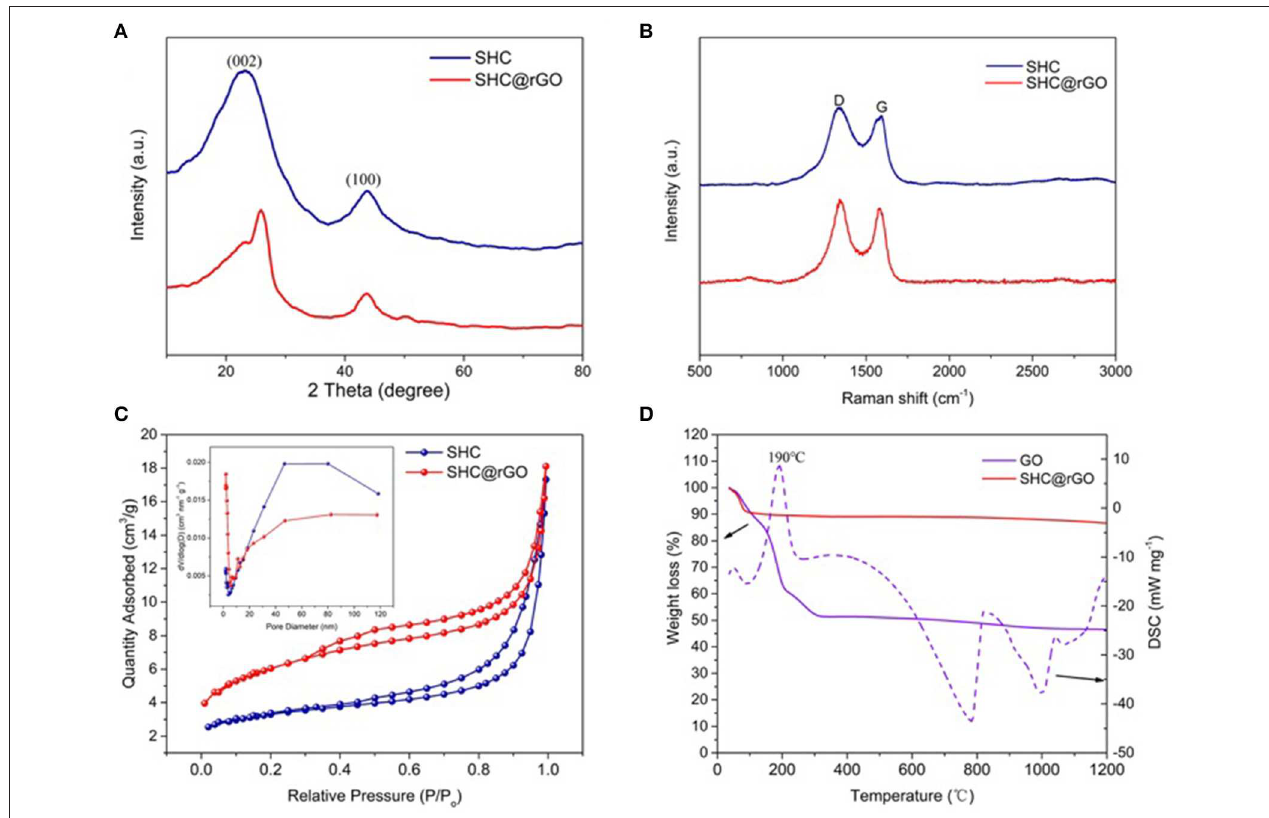
FIGURE 5 | (A) XRD patterns of SHC and SHC@rGO, (B) Raman spectra of SHC and SHC@rGO, (C) calculated pore size distribution and nitrogen adsorption isotherms (insert C) for SHC and SHC@rGO, and (D) TGA curve of the decomposition of SHC and SHC@rGO composite (Atmosphere: N 2 , heating rate: 10 ◦ C min − 1 ).